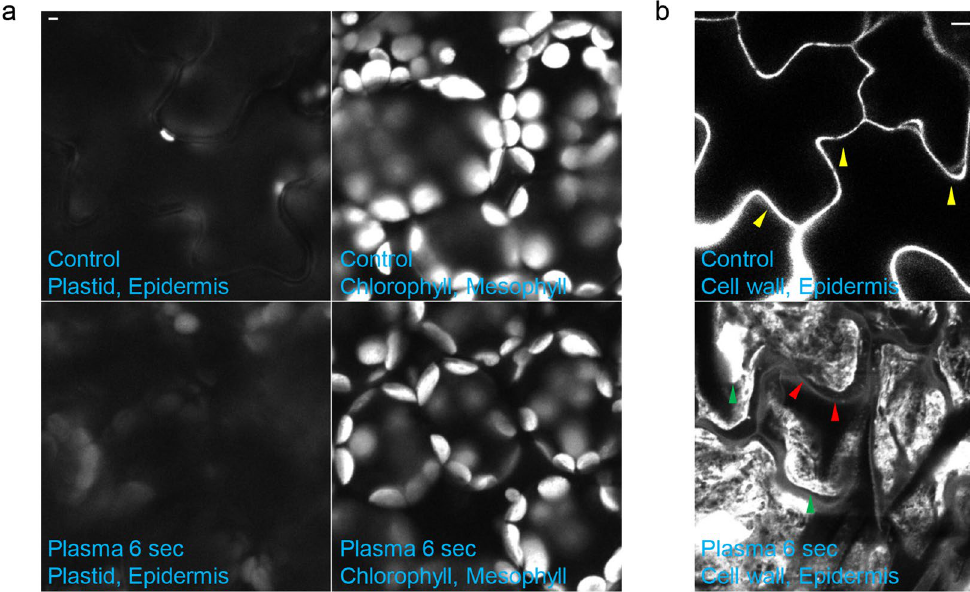
Figure 4. Epidermis layer is directly damaged through plasma treatment. ( a ) Chlorophyll auto-fluorescence image of cotyledon treated with 6 seconds of plasma or not by confocal microscope. Scale bar = 2 um. Representative image were determined from 5 experiments for each conditions. ( b ) Cell wall fluorescence image of cotyledon epidermis treated with 6 seconds of plasma or not by confocal microscope. Yellow arrowheads indicate normal cell wall signal by propidium iodide, green arrowheads indicate unknown intracellular stained propidium iodide signal, and red arrowheads indicates weak residual cell wall signal stained by propidium iodide. Representative image were determined from 5 experiments for each conditions. Scale bar = 2